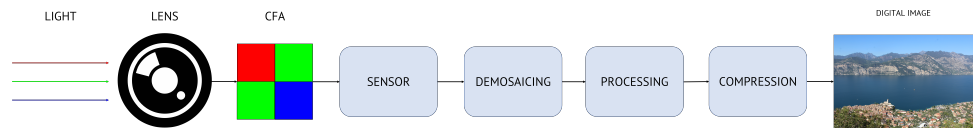
Figure 1. Typical steps of a common digital image acquisition